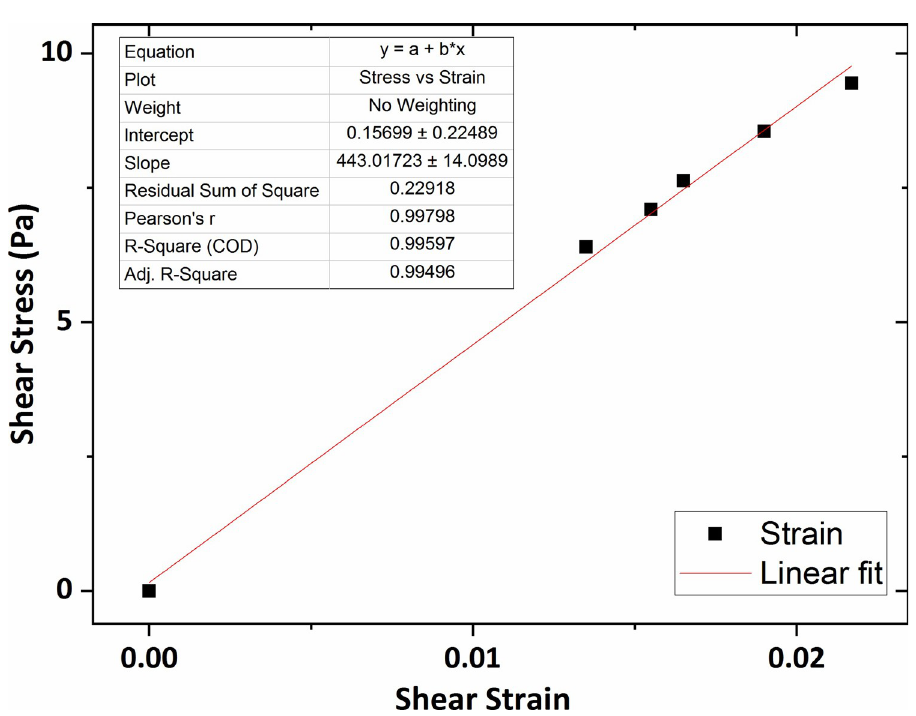
Fig 15. The graph of shear stress versus shear strain for the collagen gel of 0.4 wt % percent concentration.